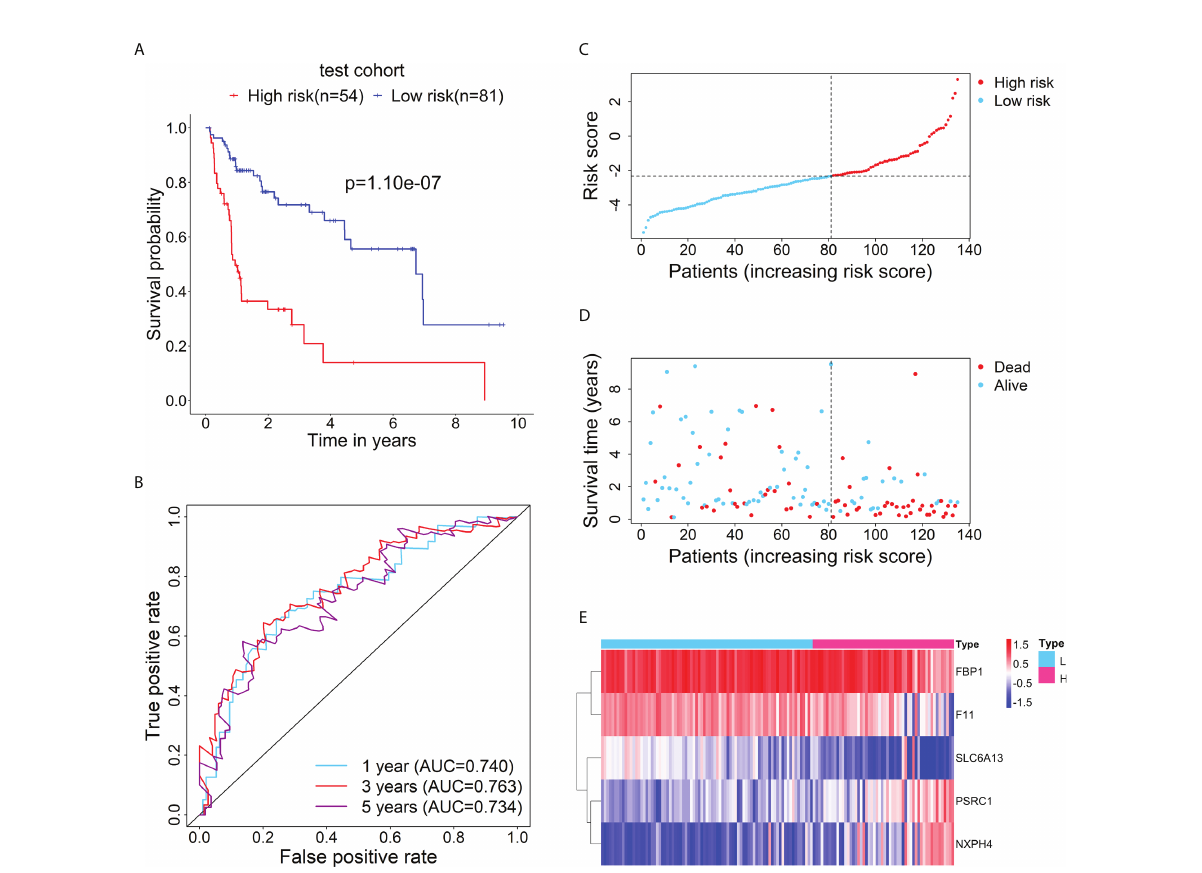
FIGURE 3 Veri fi cation for the prognostic performance of the RBP-related risk model in the test cohort. (A) Kaplan – Meier curve shows the difference in OS between the high- and low-risk groups in the test cohort. (B) The 1-, 3-, and 5-year ROC curves based on the risk score show the accuracy of the prognostic prediction of the RBP-related risk model. (C) The distribution of risk scores in the high- and low-risk groups. (D) The distribution of survival time and status of patients in the high- and low-risk groups. (E) Heatmap of clustering analysis for the expression of fi ve RBP-related mRNAs in the high- and low-risk